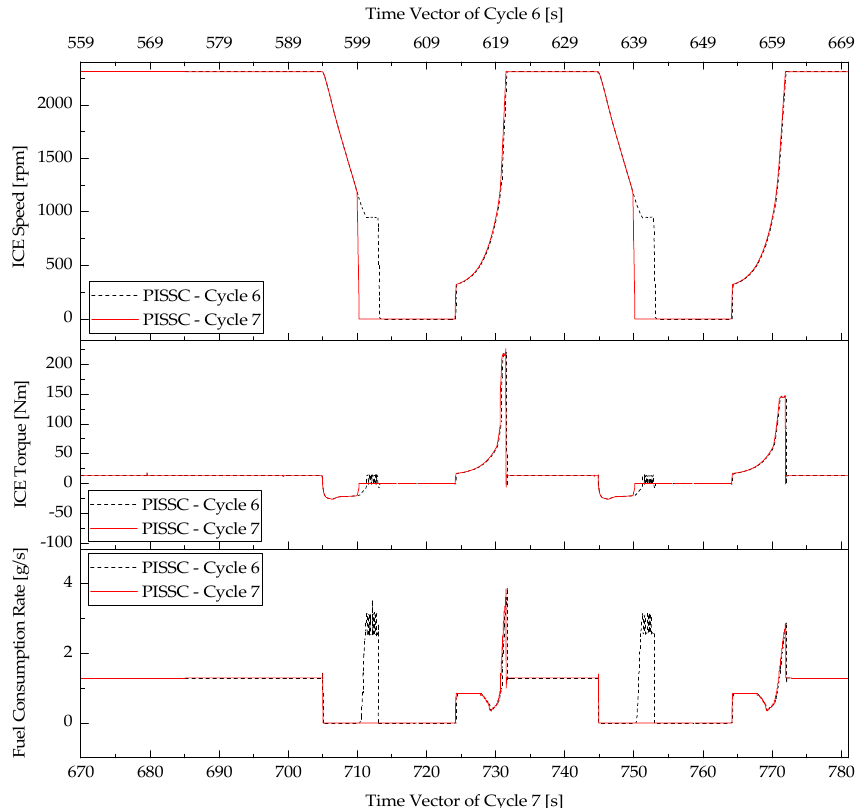
Figure 15. Comparison of ICE dynamics of HIL tests using PISSC during cycles 6th and 7th.